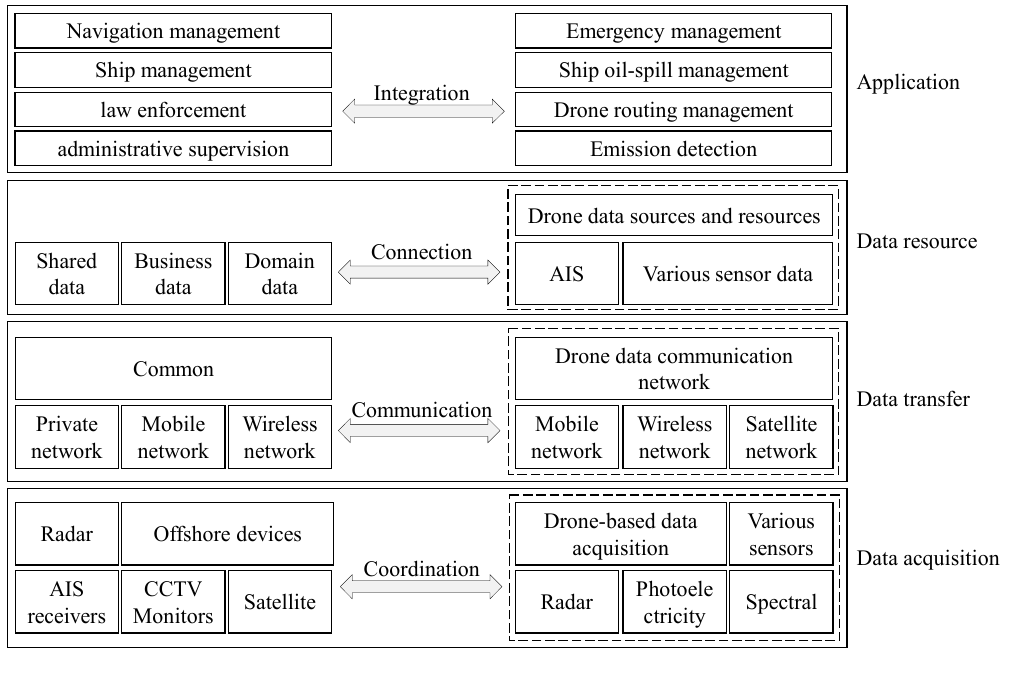
Figure 2. A system framework for drone-based ship management.